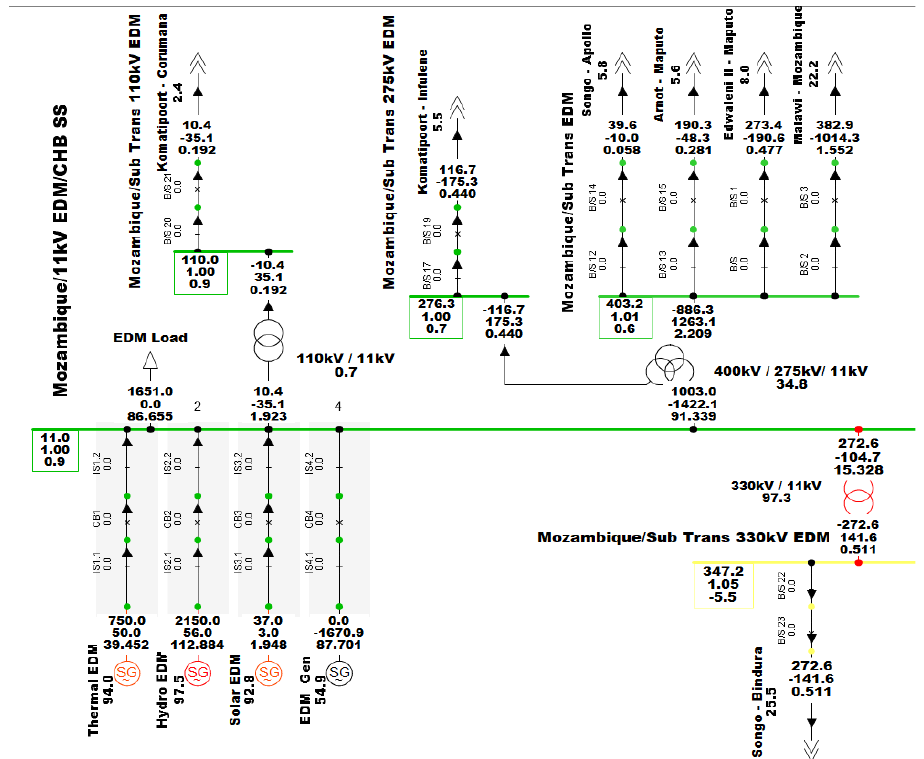
Figure 11. Voltage instability in the Mozambique electric network.